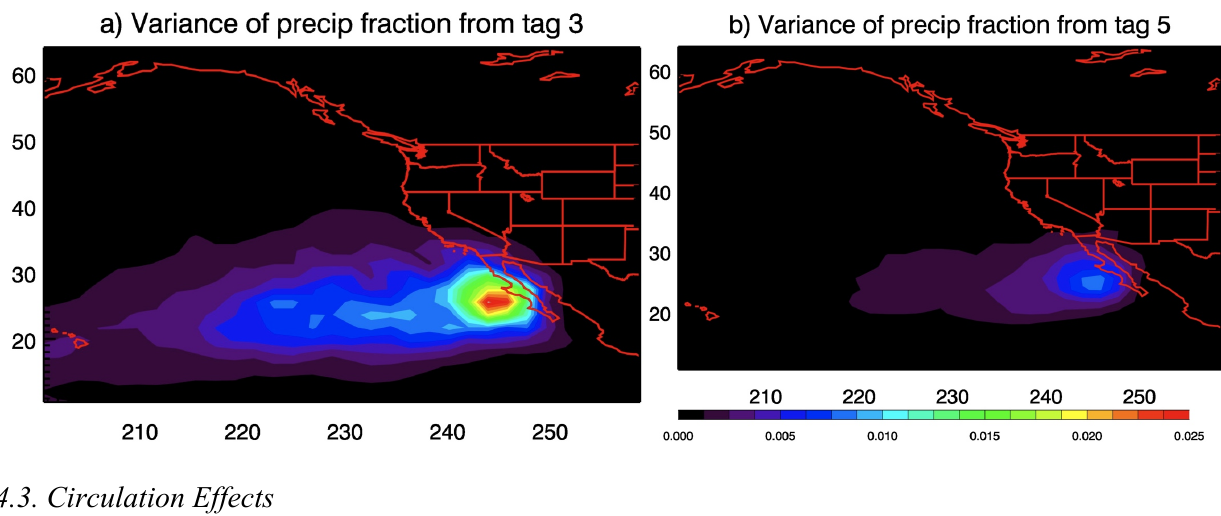
Figure 9. Interannual variance of fraction of precipitation from ( a ) vertical tag 3; and ( b ) vertical tag